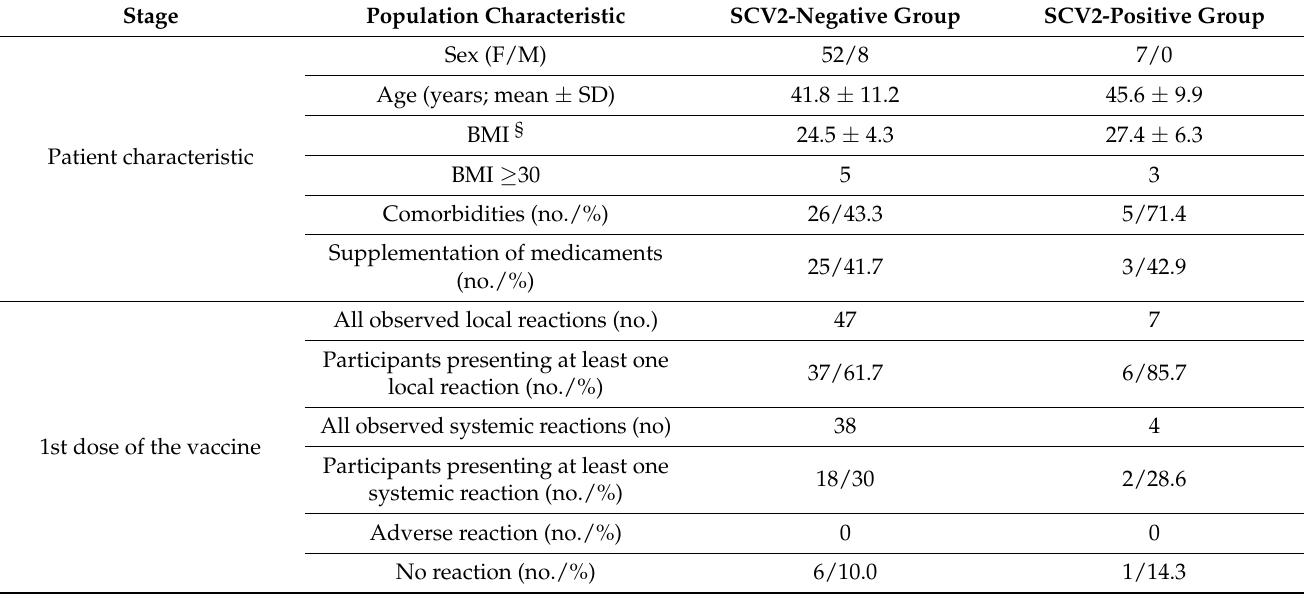
Table 1. Demographic characteristics and response to the vaccine in the studied